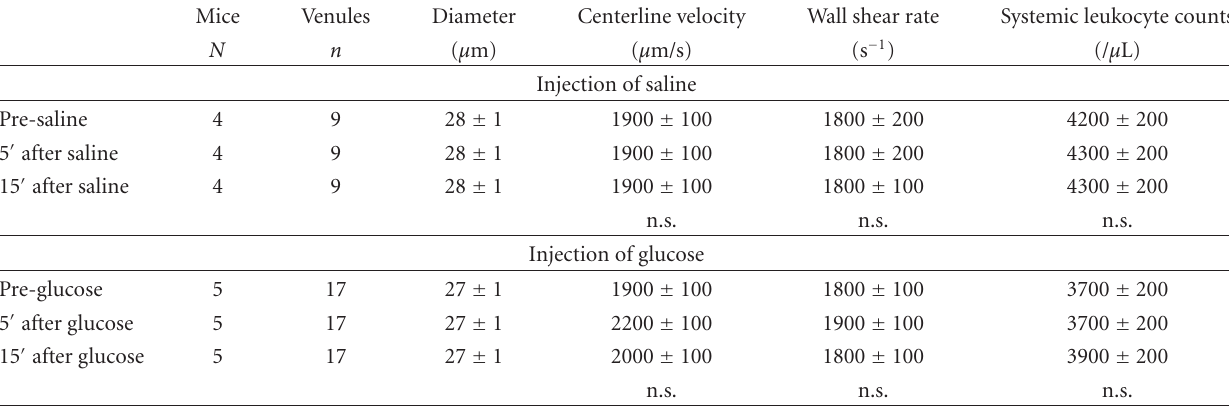
Table 2: Hemodynamic and microvascular parameters of cremaster muscle venules before and after stimulation with glucose in the TNF α model. Vessel diameter, centerline velocity, and wall shear rate are displayed before and after the intravenous administration of 0,5 g/kg glucose and compared to the application of the equivalent volume of normal saline. Experiments are presented as mean ± SEM; n.s.: not significant, stating no di ff erences of hemodynamic parameters during the time course after glucose/saline